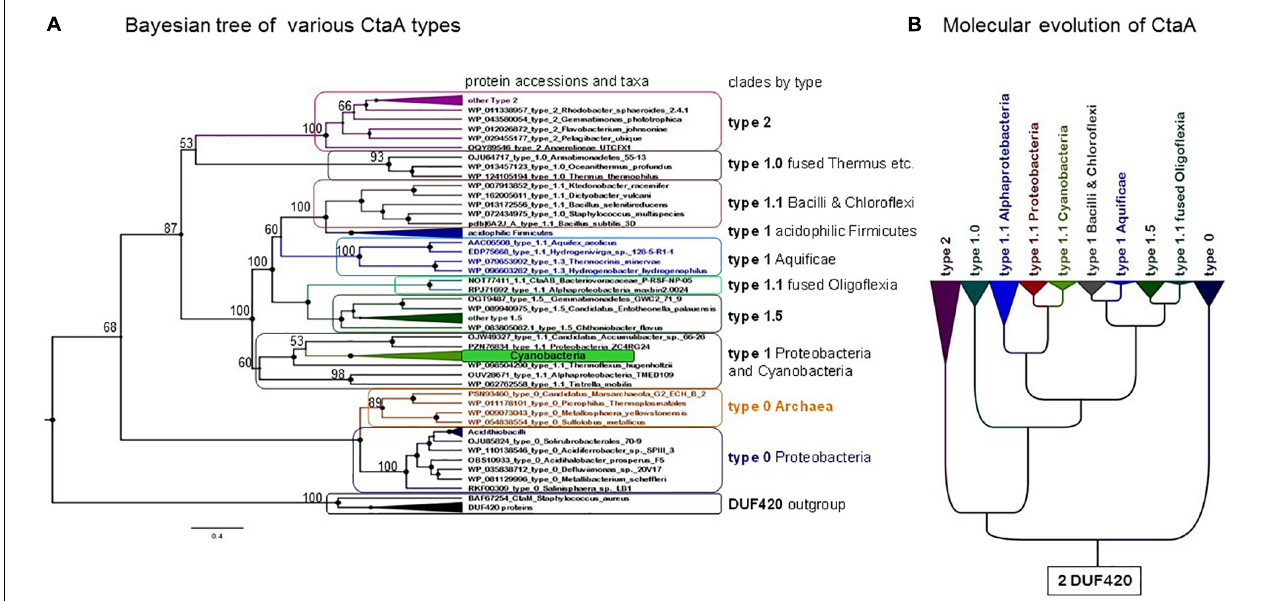
FIGURE 3 | Phylogeny and evolution of heme A synthase. (A) Bayesian Maximal Clade Credibility (MCC) tree obtained with the BEAST package using an alignment of 53 CtaA and 7 DUF420 protein sequences as the outgroup. A similar topology was seen in ML trees obtained with the same alignment and different methods ( Supplementary Figure 2 and results not shown). The alignment included 358 amino acid positions. Posterior support is expressed by the size of the dark circles on the nodes, the largest size representing 1 = 100%. Percentage values adjacent to various nodes are additionally shown. (B) Scheme for the molecular evolution of CtaA modelled on the silhouette of the Bayesian tree of bacterial CtaA proteins shown in Supplementary Figure 3 . A primordial gene (presumed to encode a 4TM DUF420 protein) was duplicated and fused in tandem to give rise to a gene encoding a type 0-like CtaA protein. During subsequent evolution of CtaA, pairs of cysteine residues in ECL1 and ECL3 have been acquired and lost, depending on the